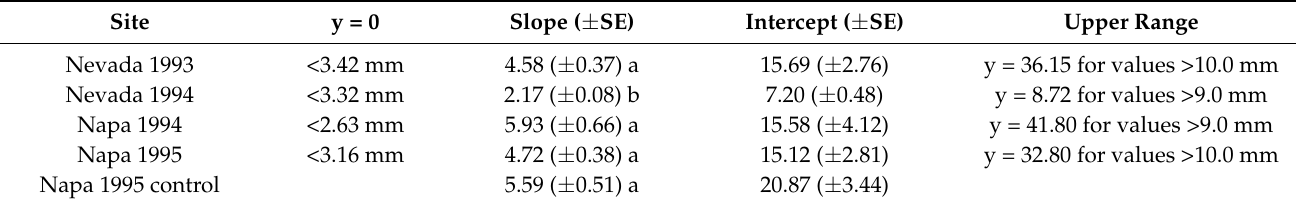
Table 6. Step functions used to predict viable seed output (y) from capitulum size (x) when Eustenopus villosus larvae were present. The data are presented in Figure 2. Linear regression predicts seed output for capitula with the following outside diameters: Nevada 1993, 3.42–10.00 mm; Nevada 1994, 3.32–9.00 mm; Napa 1994, 2.63–9.00 mm; Napa 1995, 3.16–10.00 mm. Napa 1995 control = regression of mean viable seed output against capitulum diameter for all mature capitula. Slopes followed by the same letter are not significantly different ( p < 0.05).